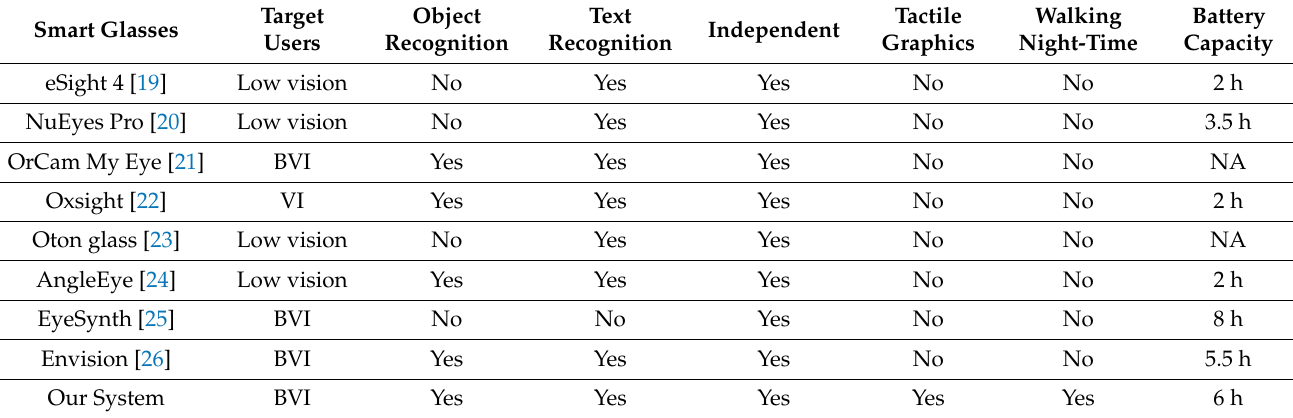
Table 1. The performance comparison of the proposed system and commercially available smart glasses. Smart